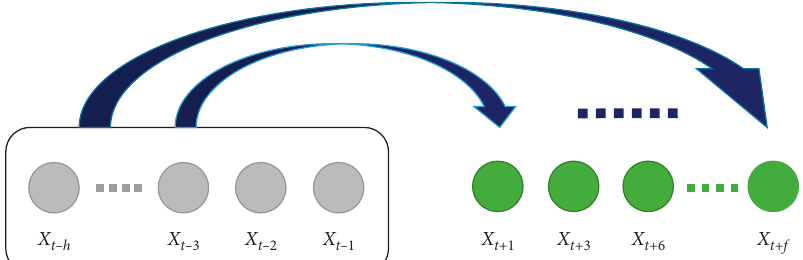
Figure 4: Multiscale